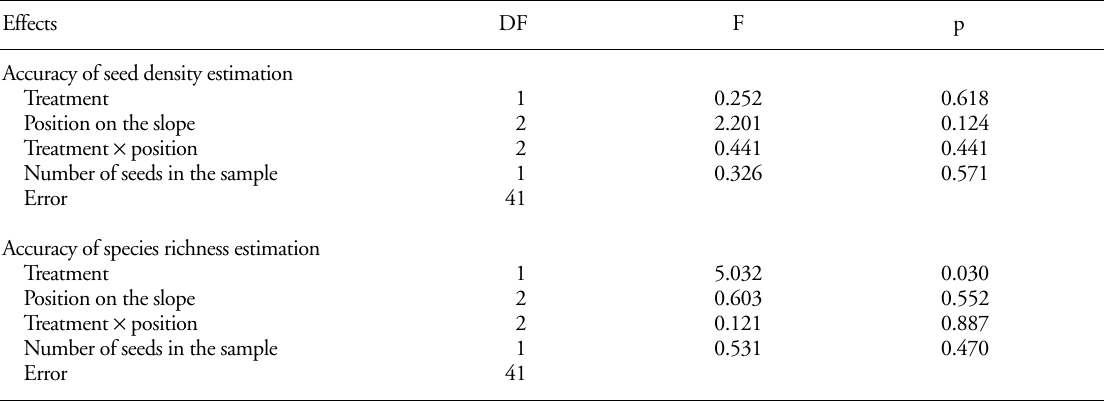
Table 1. Summary of ANCOVA results for the relationship of the accuracy of seed density and species richness estimation in the soil seed bank samples after one-year germination with the factors treatment (control vs dung removal), position on the slope (high, medium and low) and their interaction, and with the covariate number of seeds in the sample.